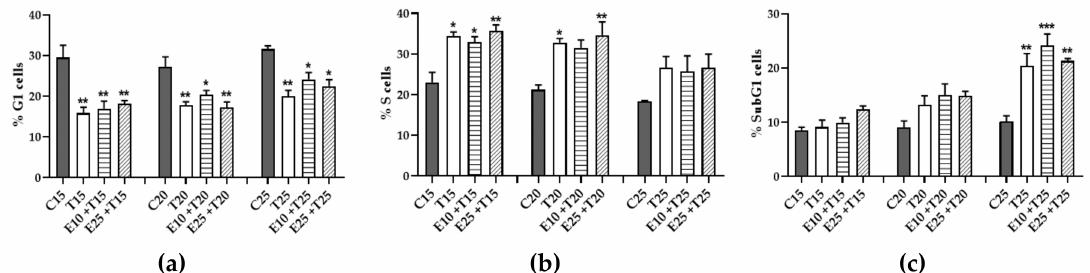
Figure 9. Flow cytometry cell cycle analysis after Rhus coriaria and UV-A treatment. Cellular population was grouped in five phases, comprising ( a ) G1 phase, ( b ) S phase, ( c ) SubG1 phase. HMEC-1 cells were treated for 1 h with 10 or 25 µ g / mL of mERC (E10, E25) and exposed to 15, 20, 25 J / cm 2 UV-A (T15, T20, T25). Results are expressed as mean ± SEM, n = 3. Statistical analysis: One-Way ANOVA with Bonferroni’s post hoc analysis. * p < 0.05 ** p < 0.01, *** p < 0.001 vs. C